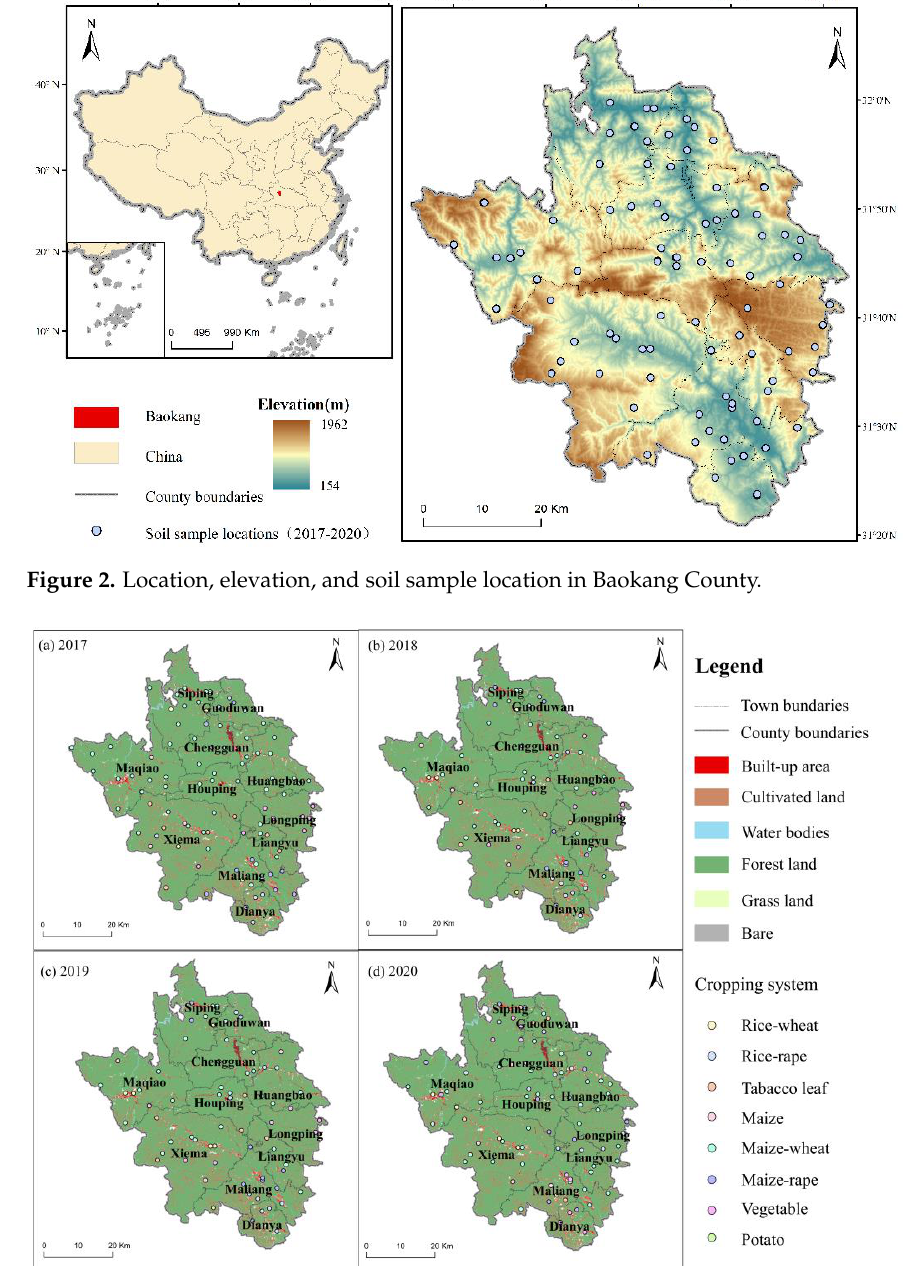
Figure 3. Cropping system distribution maps of the study area in ( a ) 2017, ( b ) 2018, ( c ) 2019, and